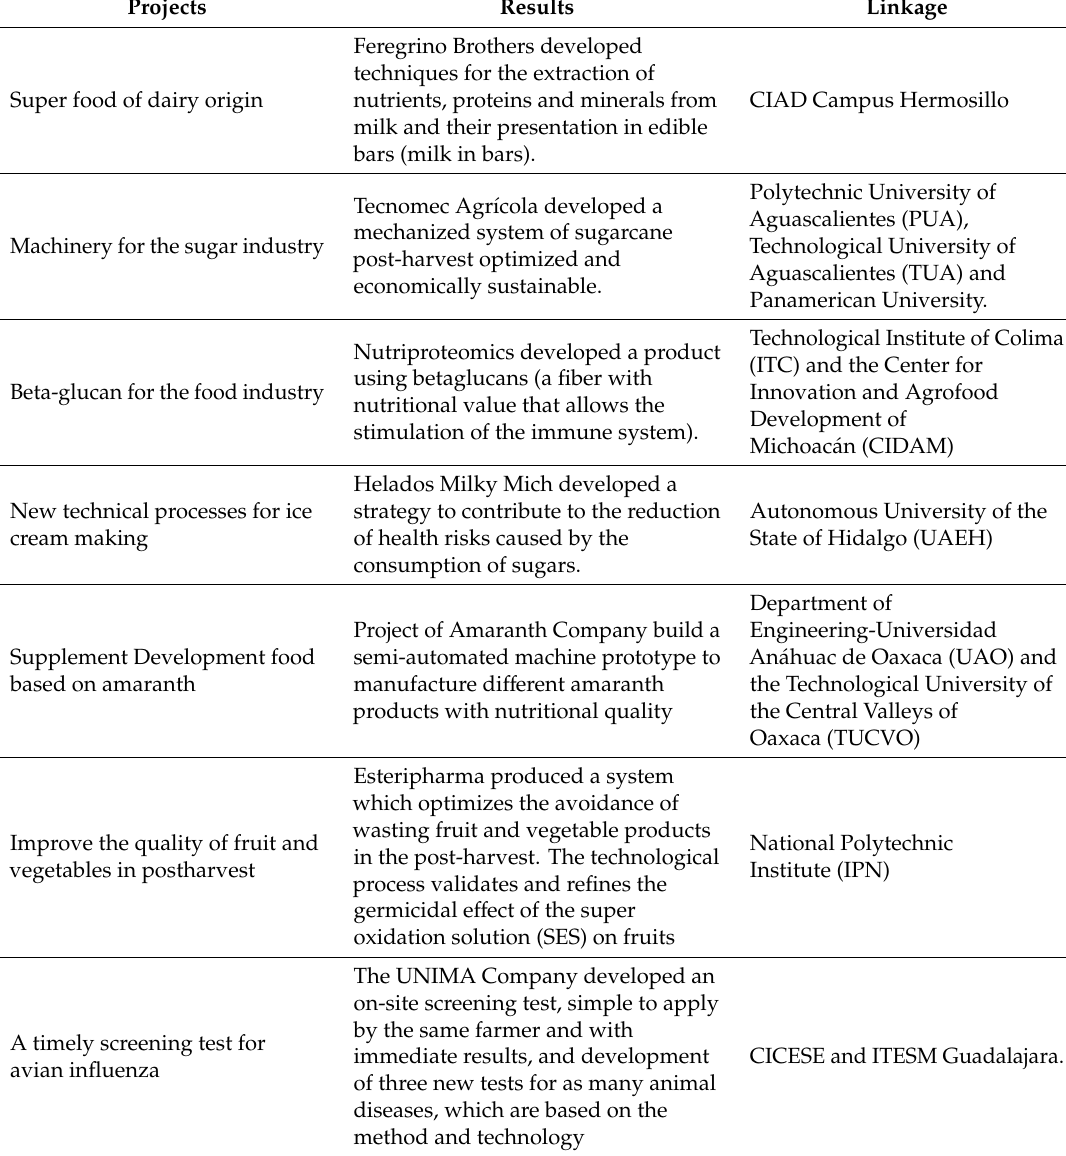
Table 1. Cases of technological transfer in Mexico. Projects supported by Innovation Incentives Program